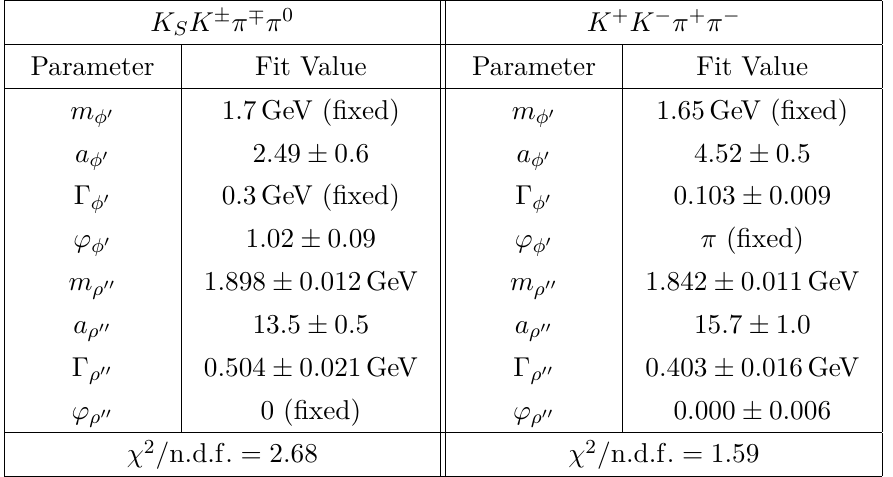
Table 5 . Values obtained by the fit to the e + e − → K ∗ Kπ → K S K ± π ∓ π 0 current (left) and to